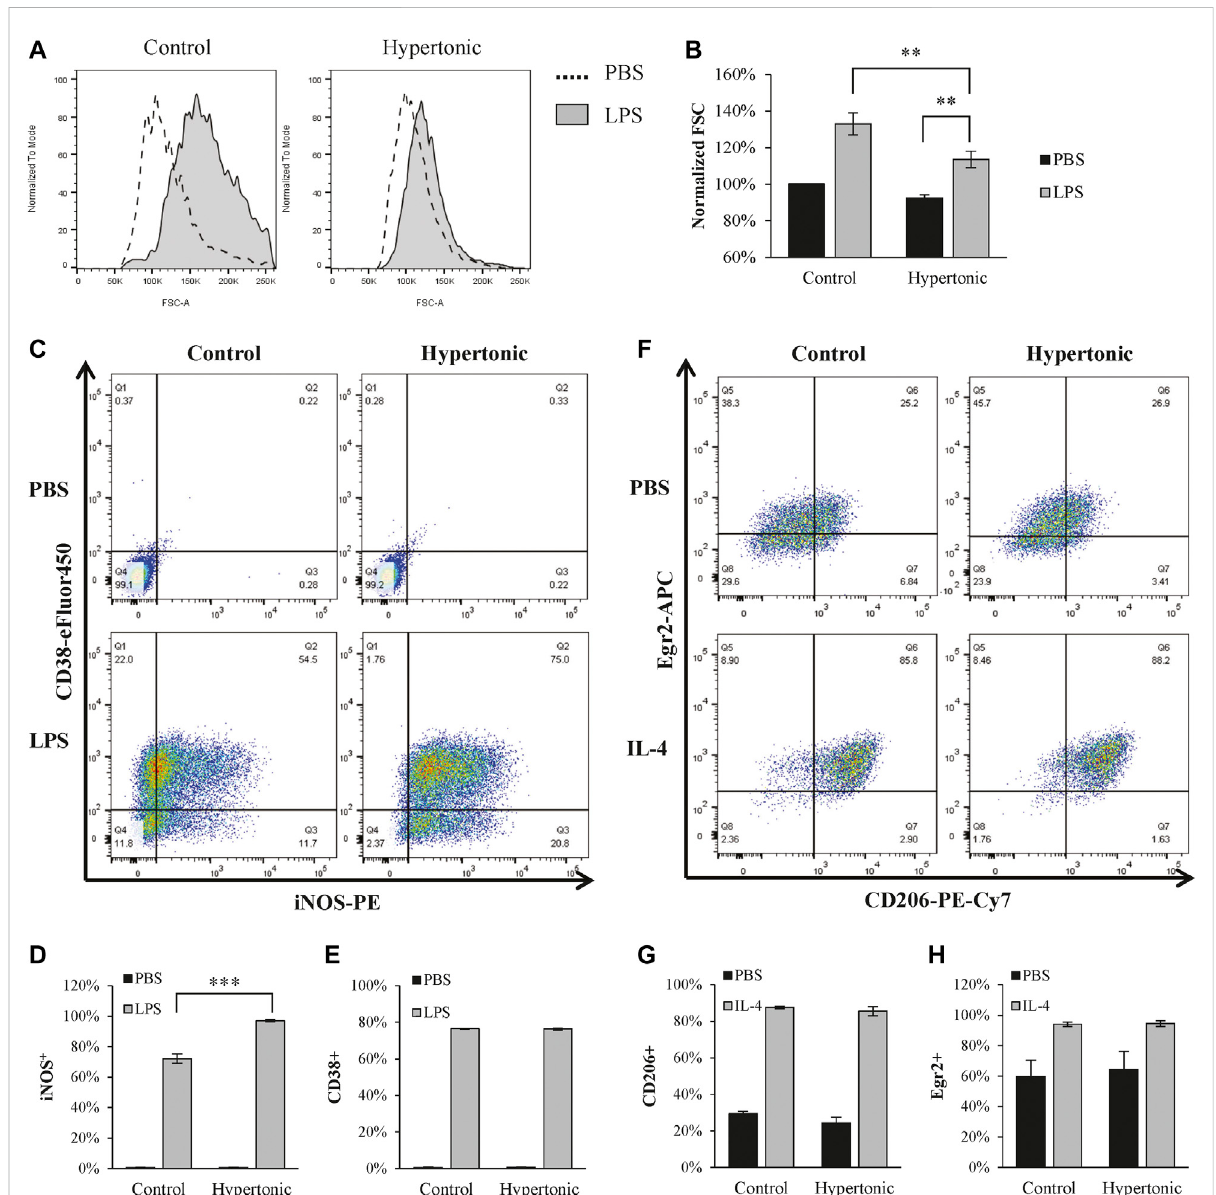
FIGURE 1 Hypertonicity induces promotes M1 polarization. (A,B) Normalized forward scatter (FCS) in fl ow cytometry was used to determine the relative cell size 24 h after tonicity (+20 mM NaCl) and LPS (1 μ g/ml) treatment. ( n = 5 – 7). (C – E) M1 polarization of BMDMs (F4/80+ and CD11b+) were estimated by iNOS and CD38 in fl ow cytometry ( n = 3). (F – H) M2 polarization of BMDMs were estimated by CD206 and Egr2 in fl ow cytometry 24 h after tonicity (+20 mM NaCl) and IL-4 (20 ng/ml) treatment ( n = 3). Values are mean ± SEM. ** p < 0.01 vs. control. *** p < 0.001 vs.